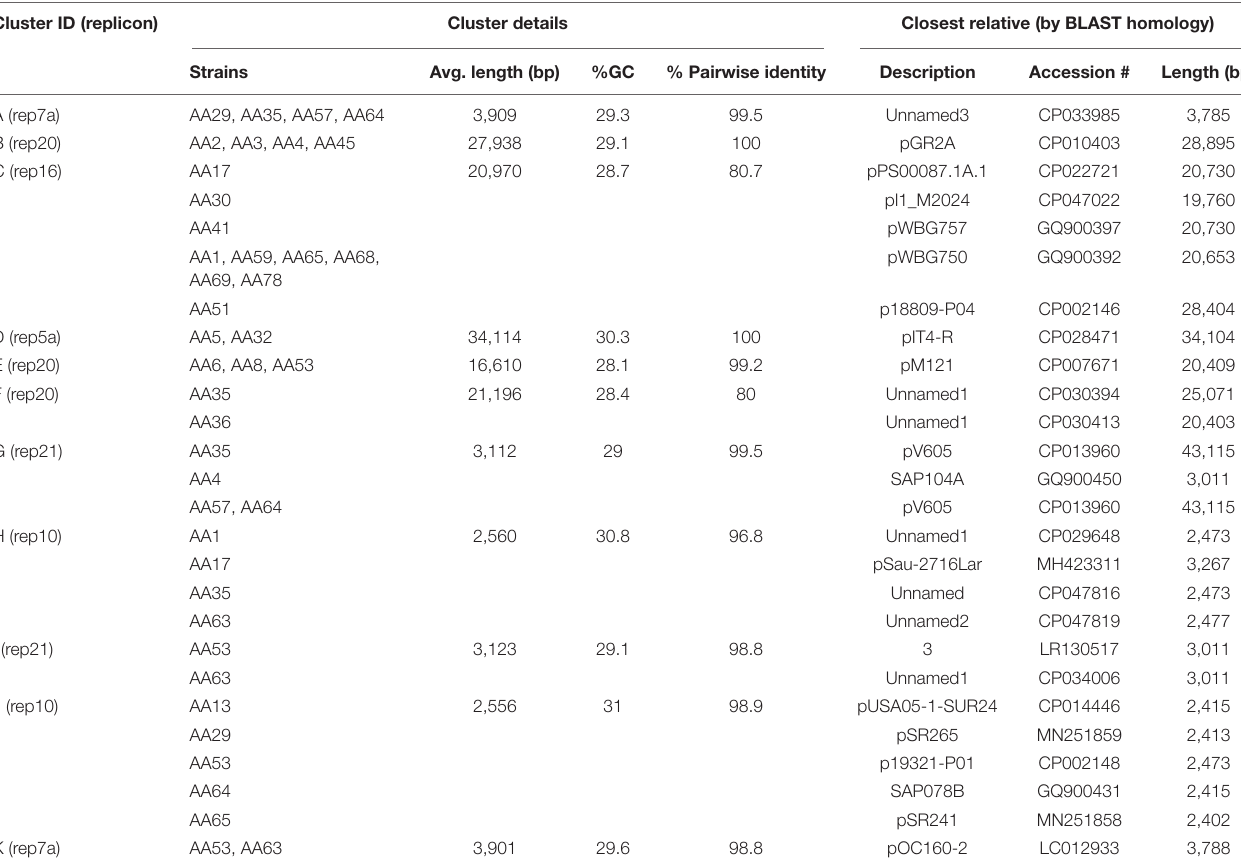
TABLE 3 | Clusters of plasmids based on nucleotide sequence similarity within the Egyptian S. aureus strains. Cluster ID (replicon) Cluster details Closest relative (by BLAST